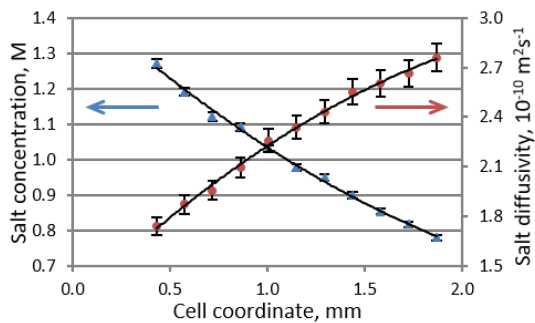
Figure 3. Steady-state Li salt concentration (blue triangles) and diffusivity (maroon circles) profiles in 1 M LiPF 6 / EC:DMC (1:1 v / v ) at a current density of 9 A m − 2 . (Reproduced with permission from [5]; 1 M LiPF 6 /EC:DMC (1:1 v/v) at a current density of 9 A m −2 . (Reproduced with permission from [5]; Copyright 2016 American Chemical Copyright 2016 American Chemical Society).